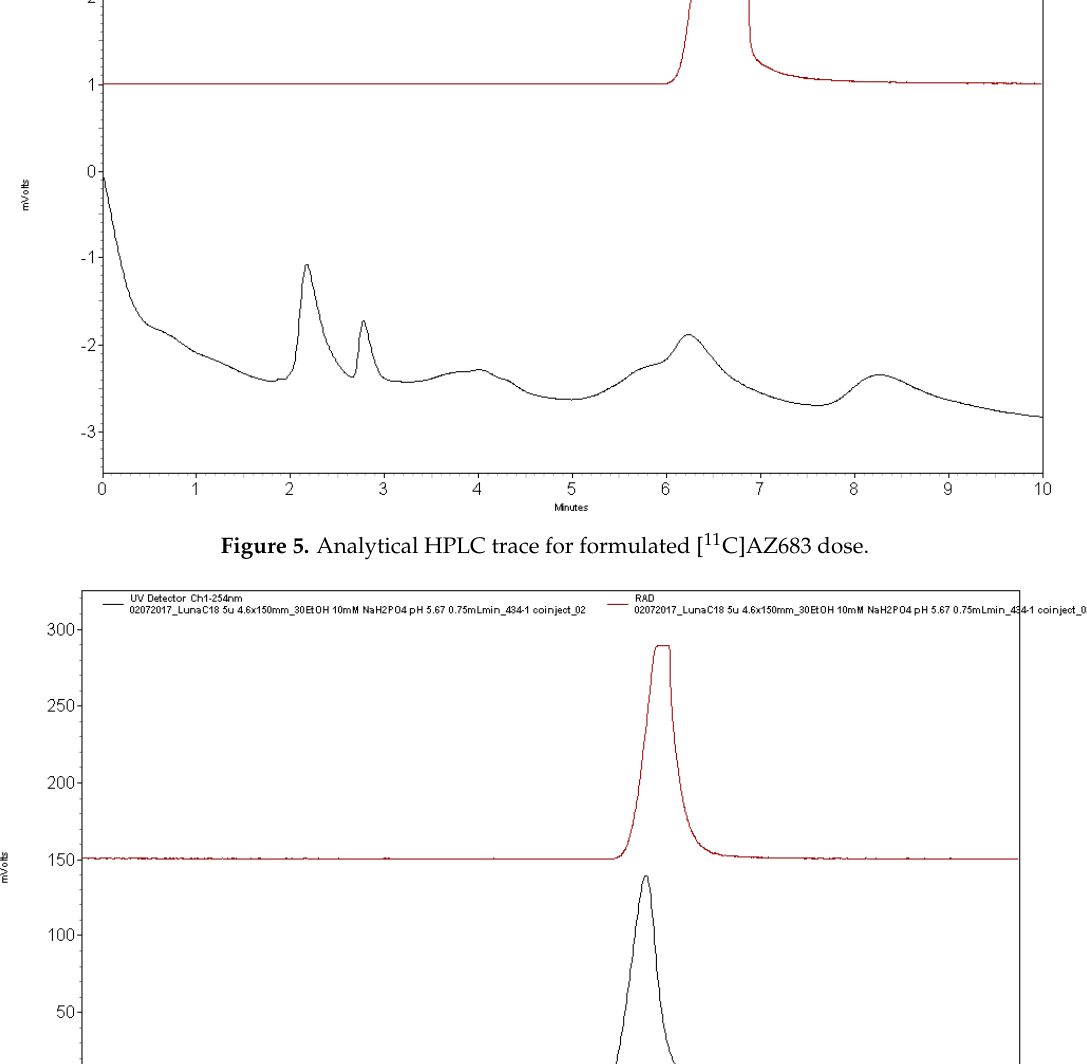
Figure 4. Typical semi-preparative HPLC trace for [ 11 C]AZ683.